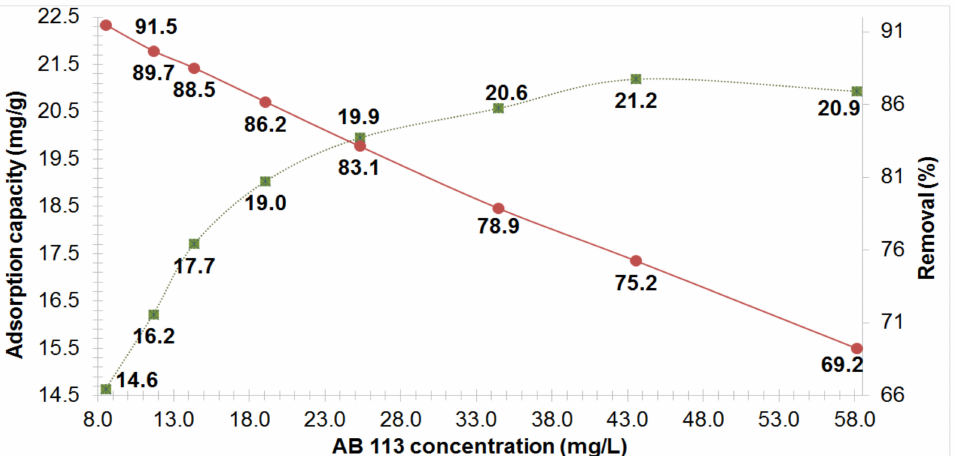
Figure 3. Effect of AB 113 initial concentration on the removal (%) and the adsorption capacity of MS